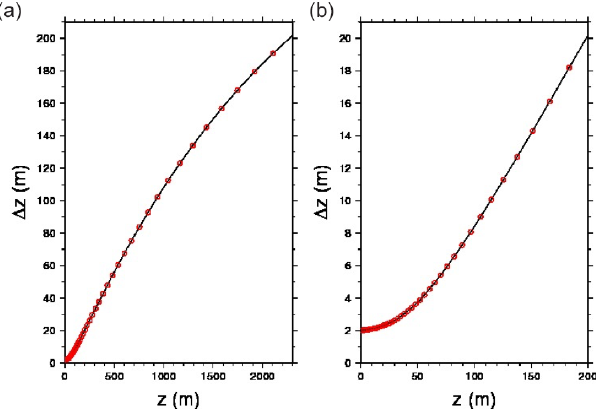
Figure 2. Model vertical grid spacing (cid:49)z (meters) as a function of the vertical coordinate z displayed for (a) maximum depth of 2300m and (b) in the upper 200m.